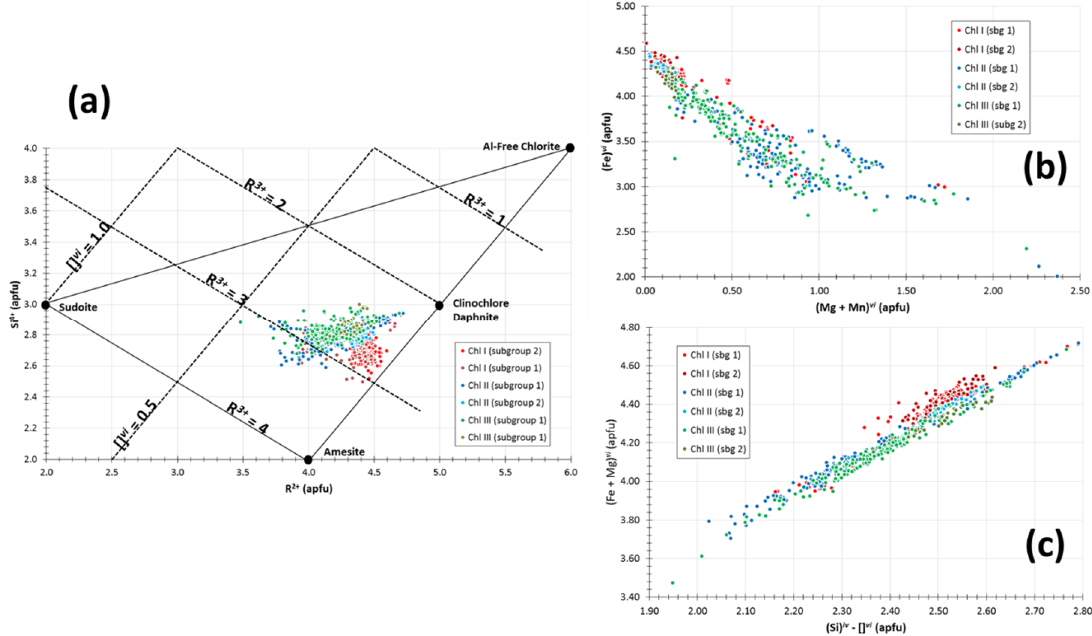
Figure 10. ( a ) Position of the analyzed chlorite in the R 2+ vs. Si 4+ diagram [169]; apfu = atoms per formula unit. Cross-plots ( b ) and ( c ) documents of the predominant exchange mechanisms operating in these chlorites.